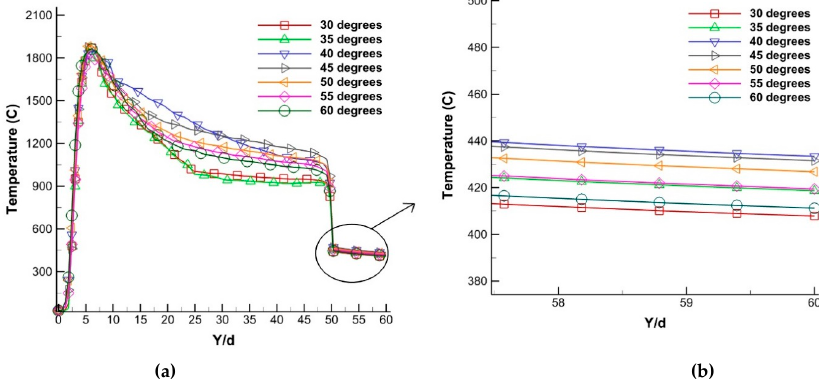
Figure 17. Effect of the guide vane angle variations on the temperature distribution: ( a ) as a function of Y/d, and ( b ) enlarged for only the steel plate thickness range. Y/d, and ( b ) enlarged for only the steel plate thickness